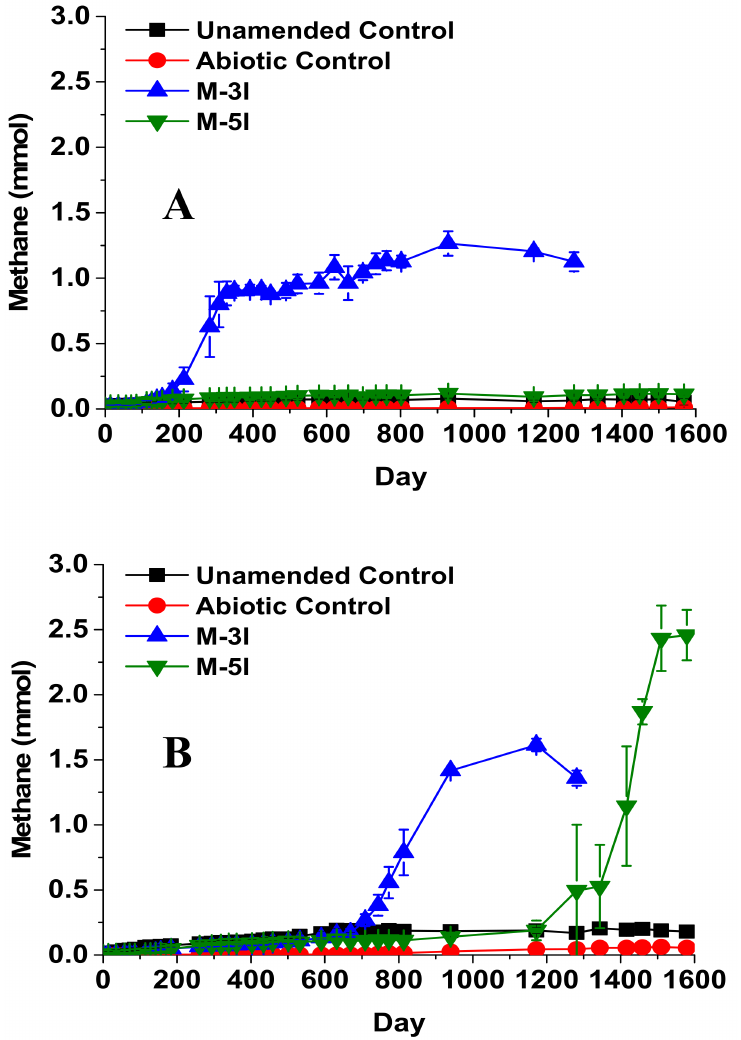
Figure 1. Cumulative methane production in microcosms containing either ( A ) CNUL MFT or ( B ) CNRL MFT, amended with iso -alkane mixtures and incubated under methanogenic conditions for ~1600 d. The three- iso -alkane mixture (M-3I) comprised 2-methylbutane (2-MC 4 ), 2-methylpentane (2-MC 5 ), and 3-methylpentane (3-MC 5 ), whereas five- iso -alkane mixture (M-5I) comprised 2-MC 4 , 2-MC 5 , 2-methylhexane (2-MC 6 ), 2-methylheptane (2-MC 7 ), and 2-methyloctane (2-MC 8 ). Symbols represent the mean value of measurements from triplicate microcosms and error bars, where visible, represent one standard